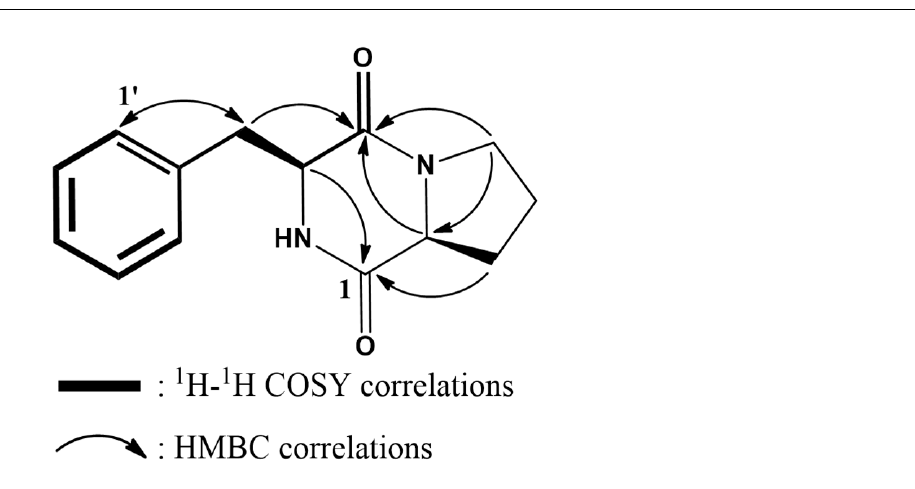
Figure 7. Chemical structure of the purified cyclic dipeptide, cyclo-(D-phenylalanyl-D-prolyl). Table 1. 1 H (500 MHz) and 13 C (125 MHz) NMR data of cyclo-( D -phenylalanyl- D -prolyl) in CD 3 OD.